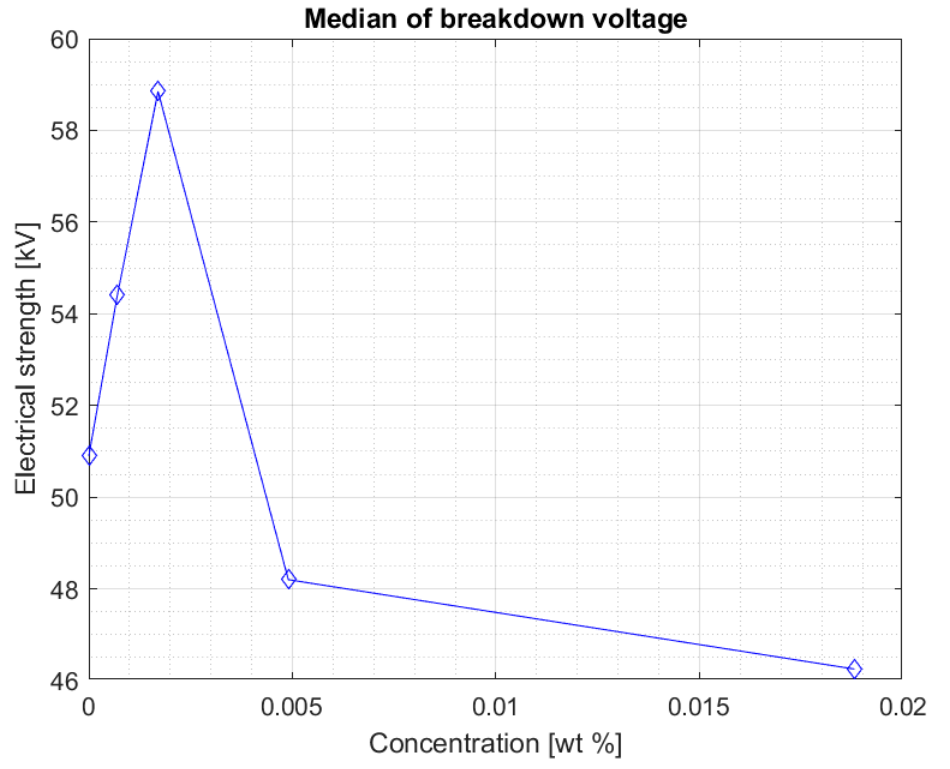
Figure 7. Median of measurement results for each nanofluid seven weeks after